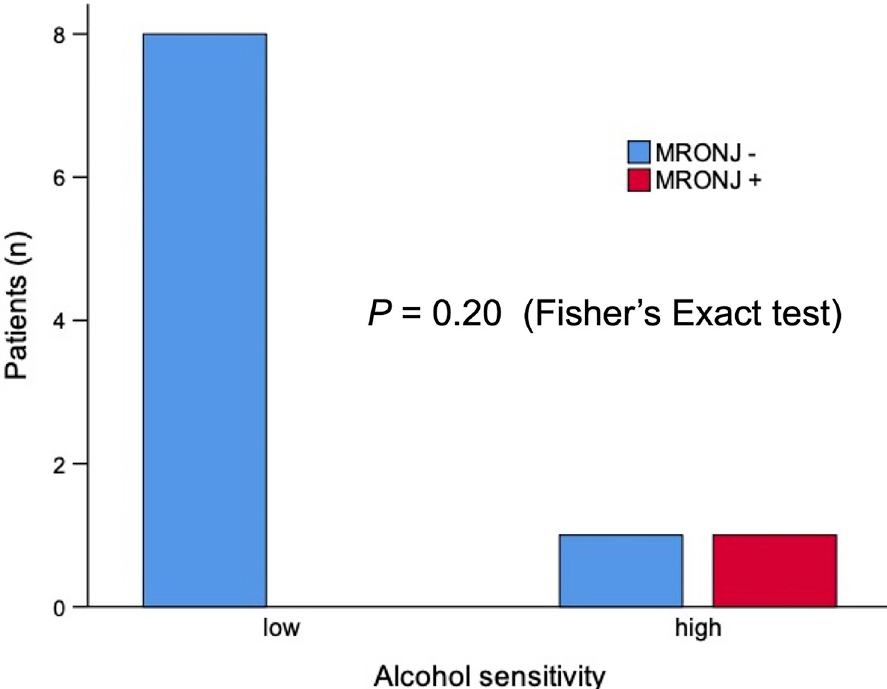
Fig 4. Alcohol-sensitivity and MRONJ in patients administered bone-modifying agents. MRONJ, medication- related osteonecrosis of the jaw.